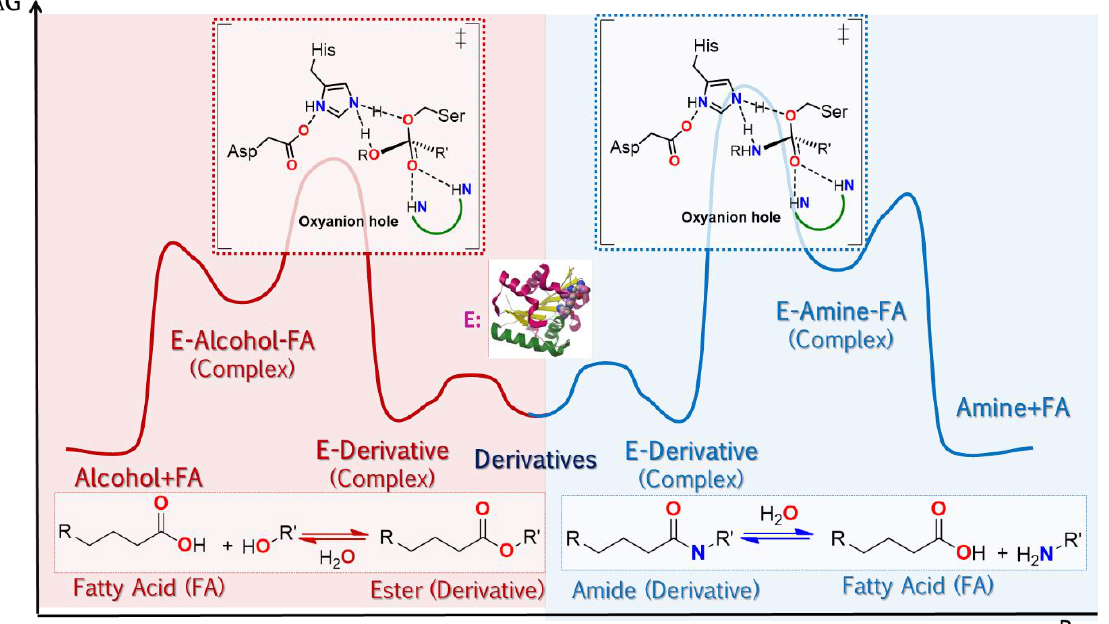
Figure 6. Schematic reaction coordinate vs. potential energy diagram for lipases, showing the transition state (‡) for each case. Representation of condition promiscuity: lipase can catalyze the hydrolysis of triglycerides (in the scheme, from the center towards the left), and under adequate circumstances, to catalyze reactions in the opposite direction (esterification). In addition, substrate promiscuity is present ( left ): they are capable of hydrolyzing other carboxylic acid derivatives such as amides or synthesize them from amines and carboxylic acids, here it can be seen that the difference between transition states (‡) is precisely the nucleophile involved. [133].